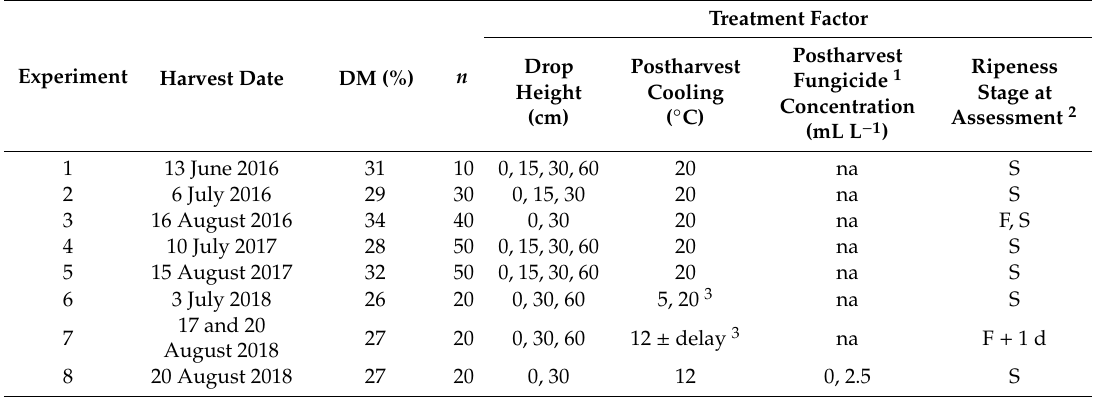
Table 1. Summary of experiment time, fruit dry matter (DM) at harvest, treatment sample size ( n ) and treatment details for each of the eight